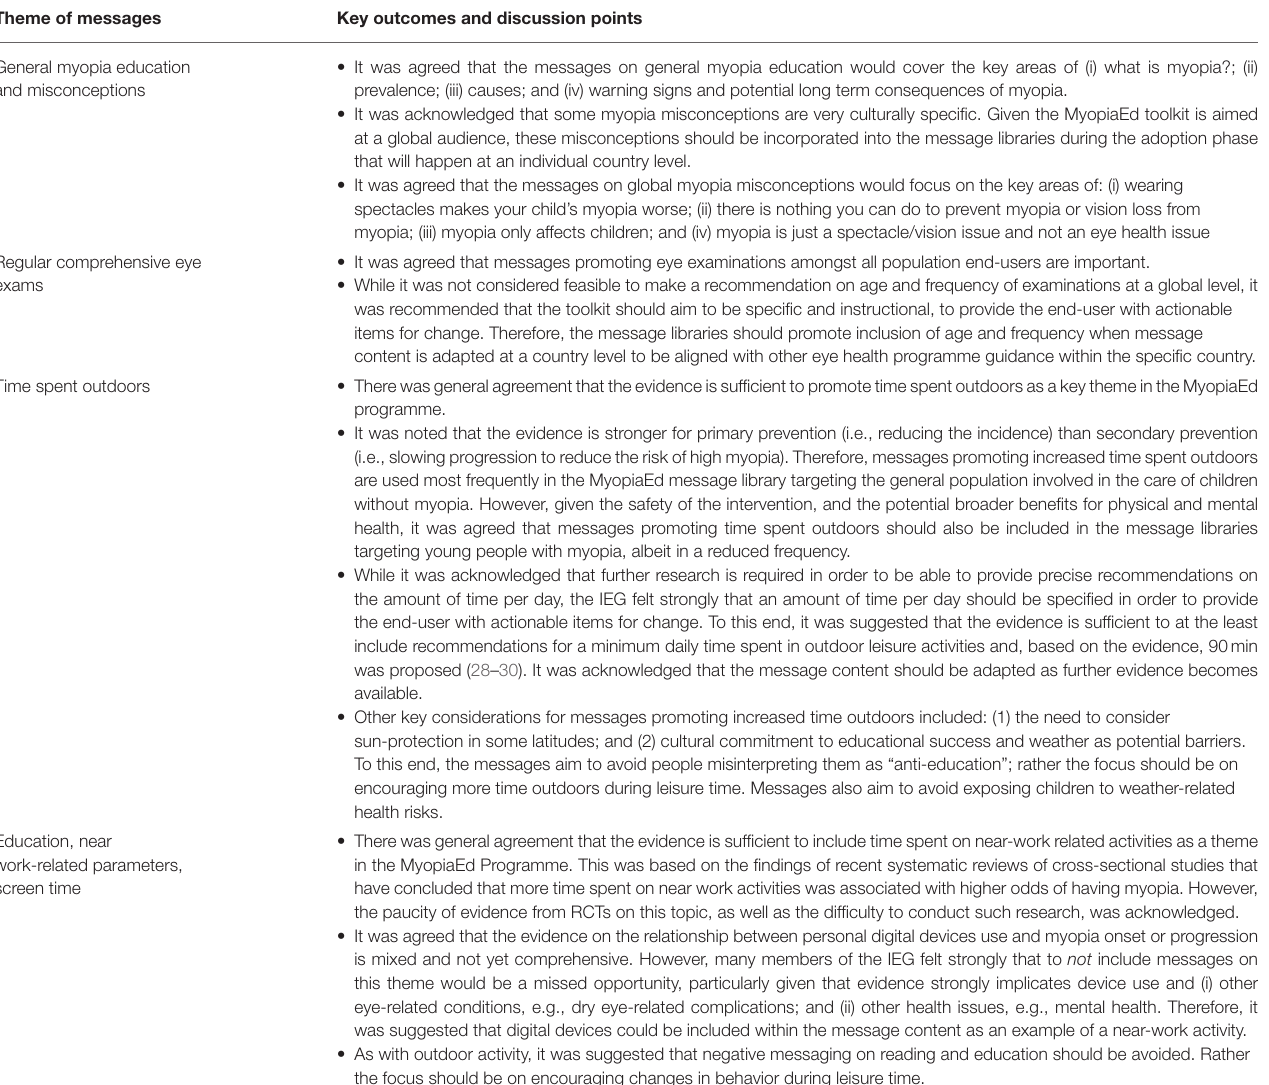
TABLE 1 | A summary of the key outcomes of the WHO consultation on the proposed themes of the MyopiaEd Programme. Theme of messages Key outcomes and discussion